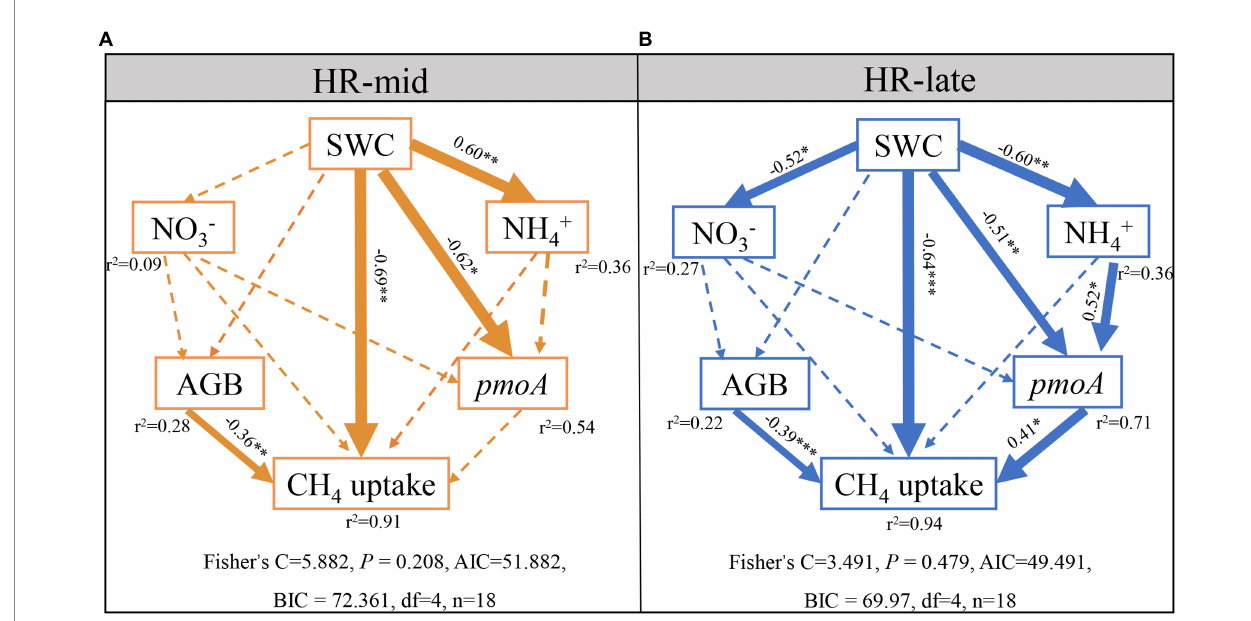
FIGURE 4 Structural equation models analysis of the direct and indirect effects of soil, microbe and plant variables on CH 4 uptakes under HR-mid (A) and HR-late (B) treatment. SWC: soil water content; AGB: aboveground, biomass; NH 4+ and NO 3 − : soil ammonium and nitrate content. Solid and dashed lines indicate significant ( p ≤ 0.05) and nonsignificant ( p > 0.05) relationships, respectively. Width of the line is proportional to the strength of path coefficients expressed by the numbers adjacent on lines. r 2 values denote the proportion of variance explained for each